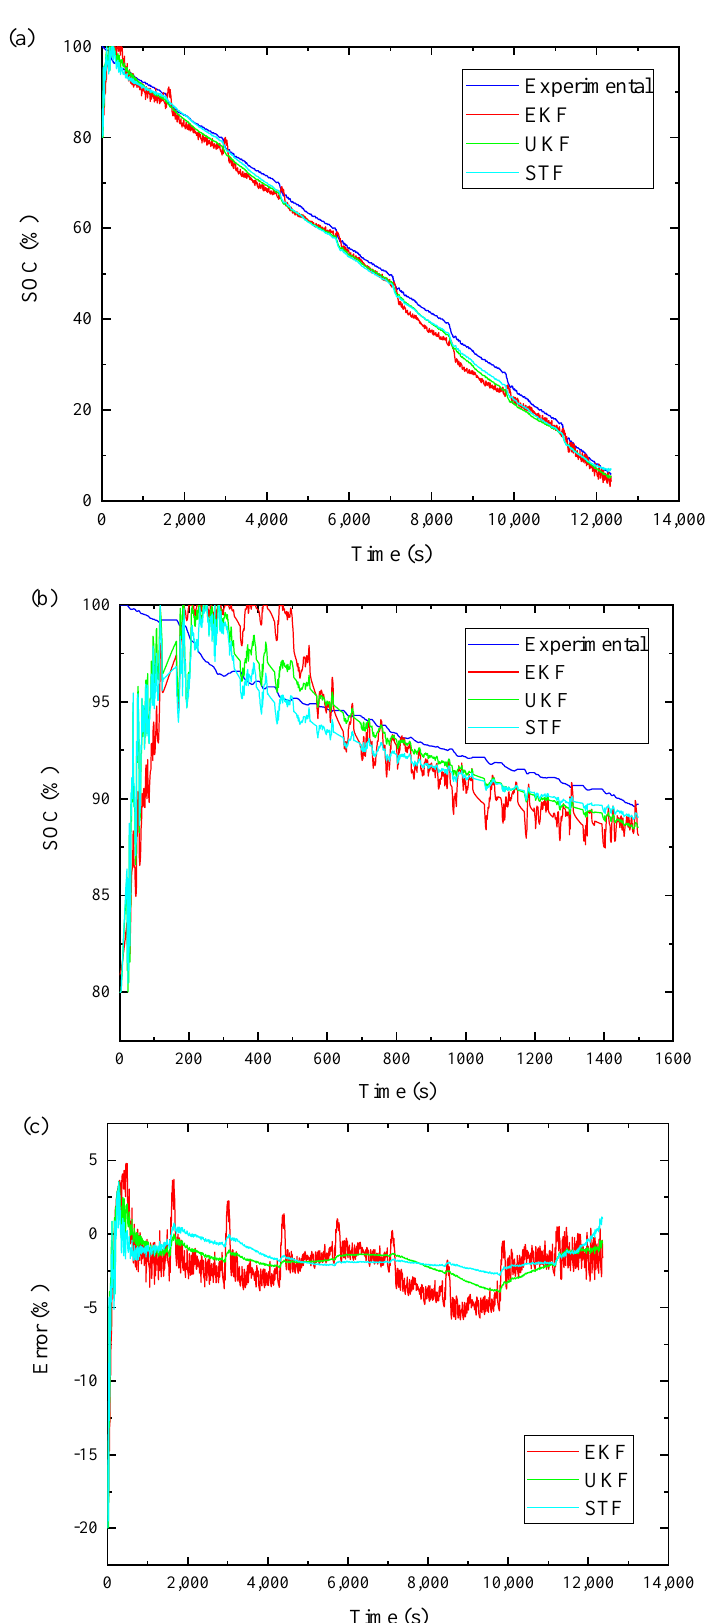
Figure 14. Robustness performance results with a SOC guess of 80% at a temperature of 0 °C : ( a ) SOC estimation results; ( b ) the enlarged window from 0 to 1500 s; ( c ) SOC estimation error.